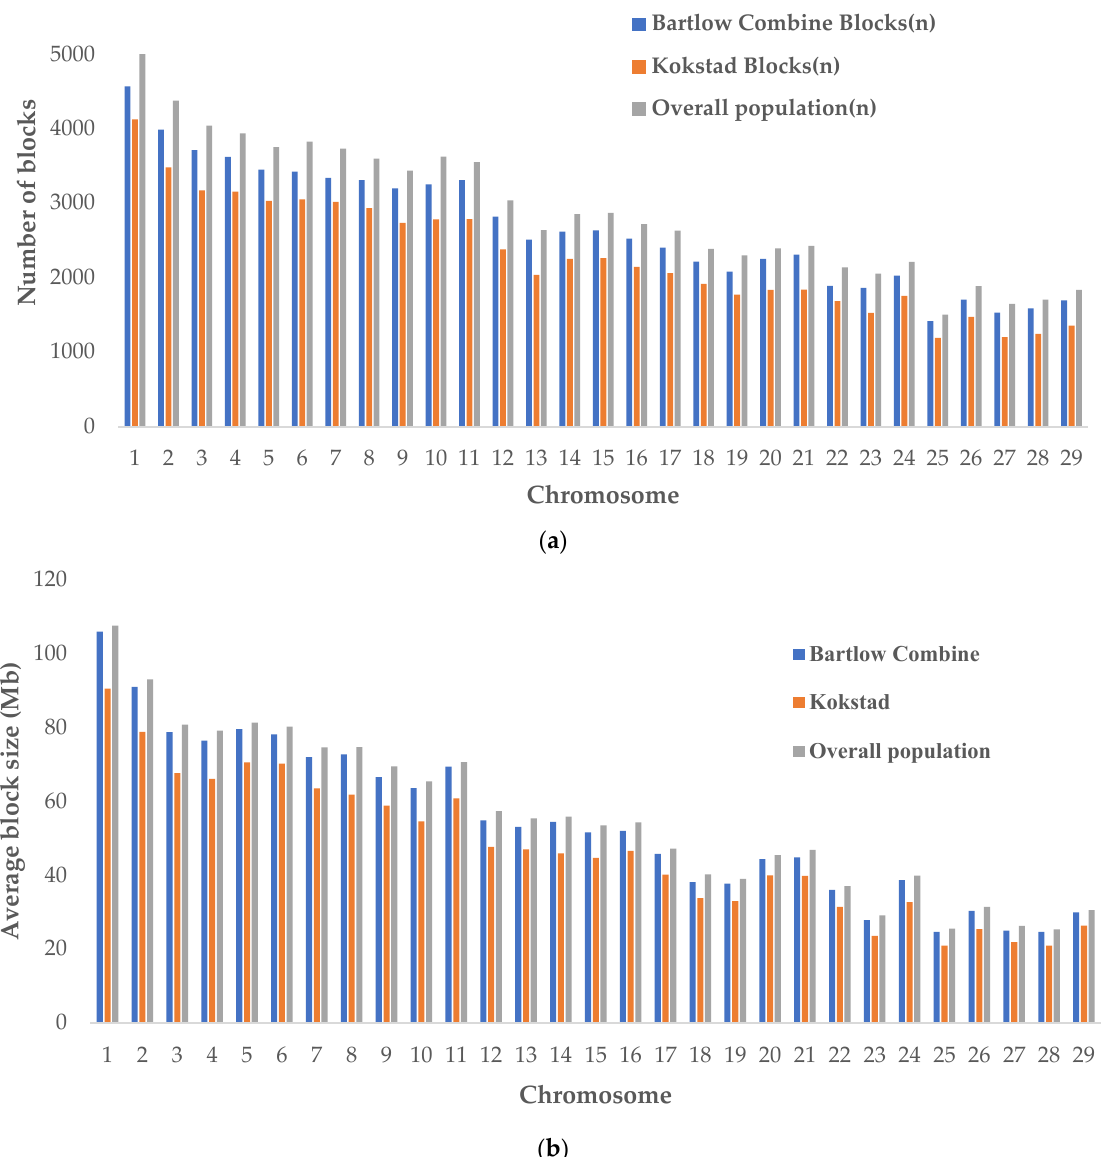
Figure 4. ( a ) Distribution of haploblocks per chromosome in Bartlow Combine, Kokstad, and overall Nguni cattle populations. ( b ) The average block size in the genomes of Bartlow Combine, Kokstad, and overall Nguni cattle populations.